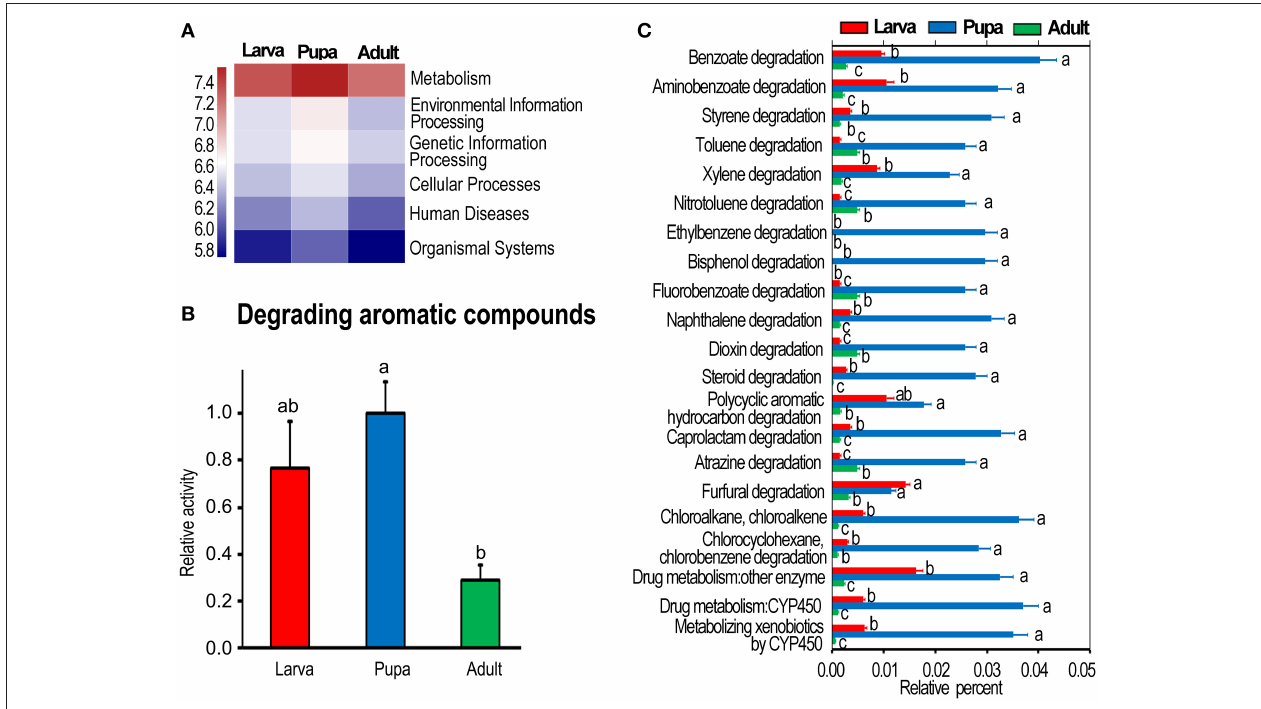
FIGURE 1 | Kyoto Encyclopedia of Genes and Genomes (KEGG) analysis of bacterial flora in Leptinotarsa decemlineata . (A) Shows whole metabolism activities at KEGG level 1. The relative activities in (B) are the ratios of relative percentages in larvae and adults relative to that in the pupae, which is set as 1. (C) Displays the relative activity (percentage) of individual aromatics in the larvae, pupae, and adults at the third KEGG level. The columns represent averages with vertical lines indicating SE. Different letters indicate a significant difference at p- value < 0.05 using analysis of variance with the Tukey–Kramer